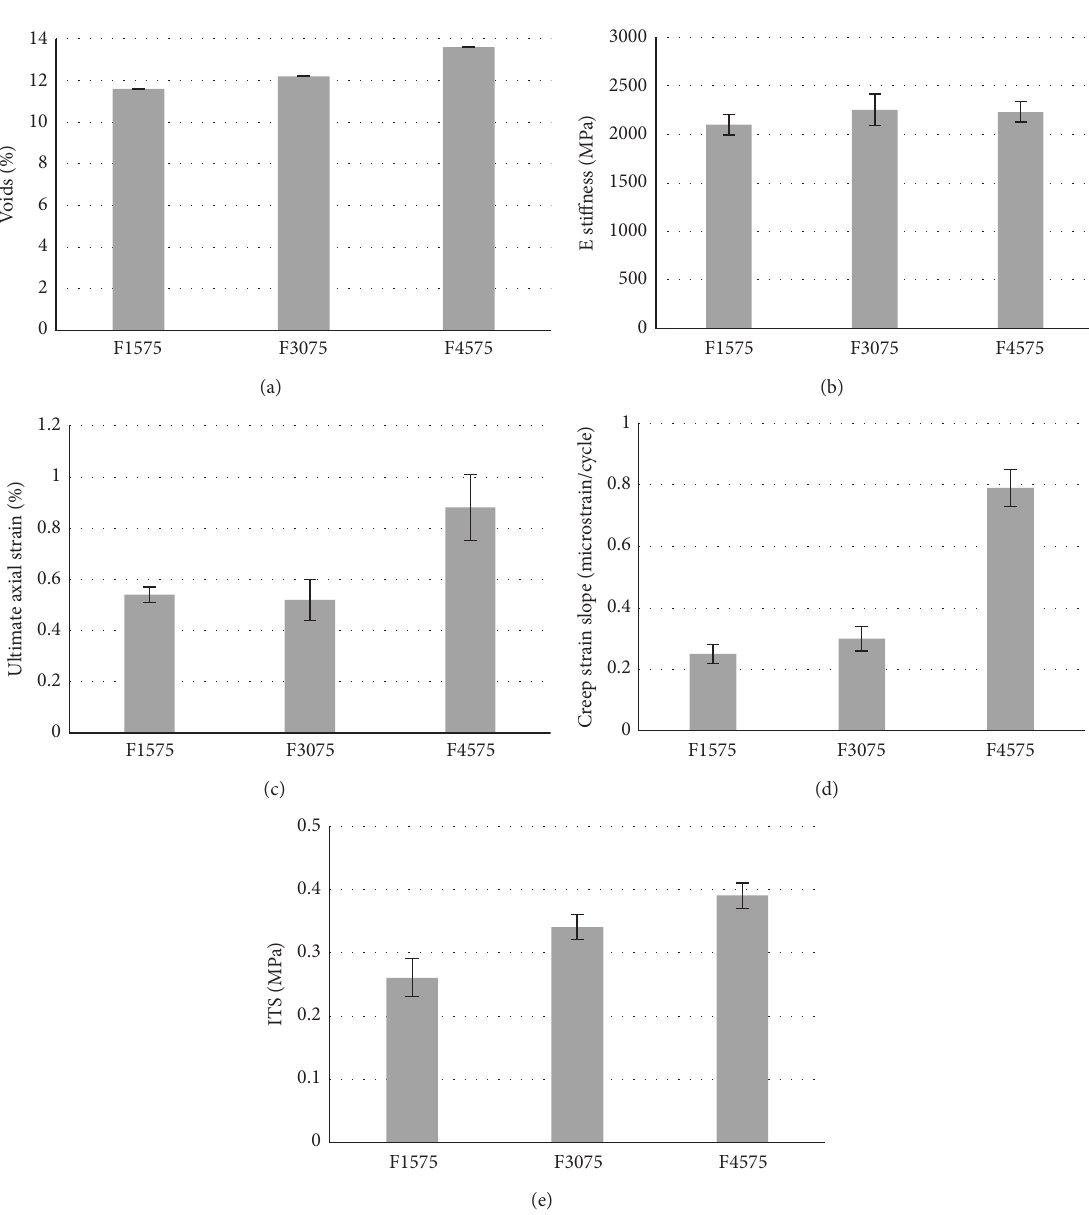
Figure 4: Effect of FB content on mixtures containing 75 % OMC: (a) voids, (b) stiffness, (c) UAS, (d) CSS, and (e) ITS. E: Stiffness